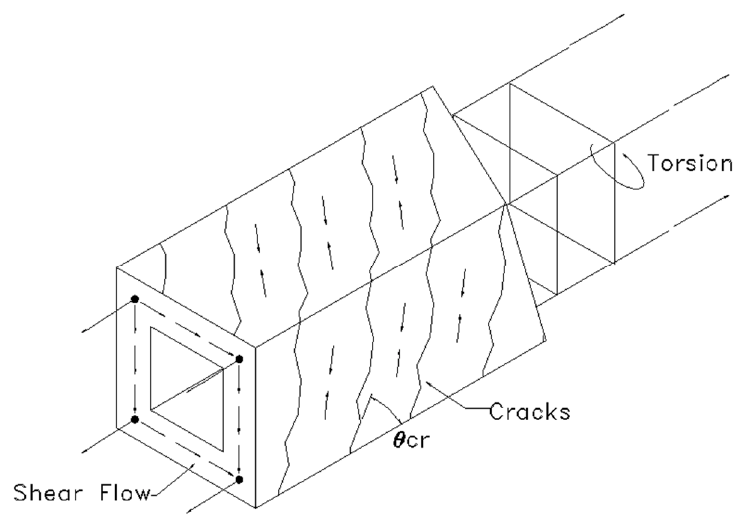
Figure 1. Space truss idealisation of beams in torsion.